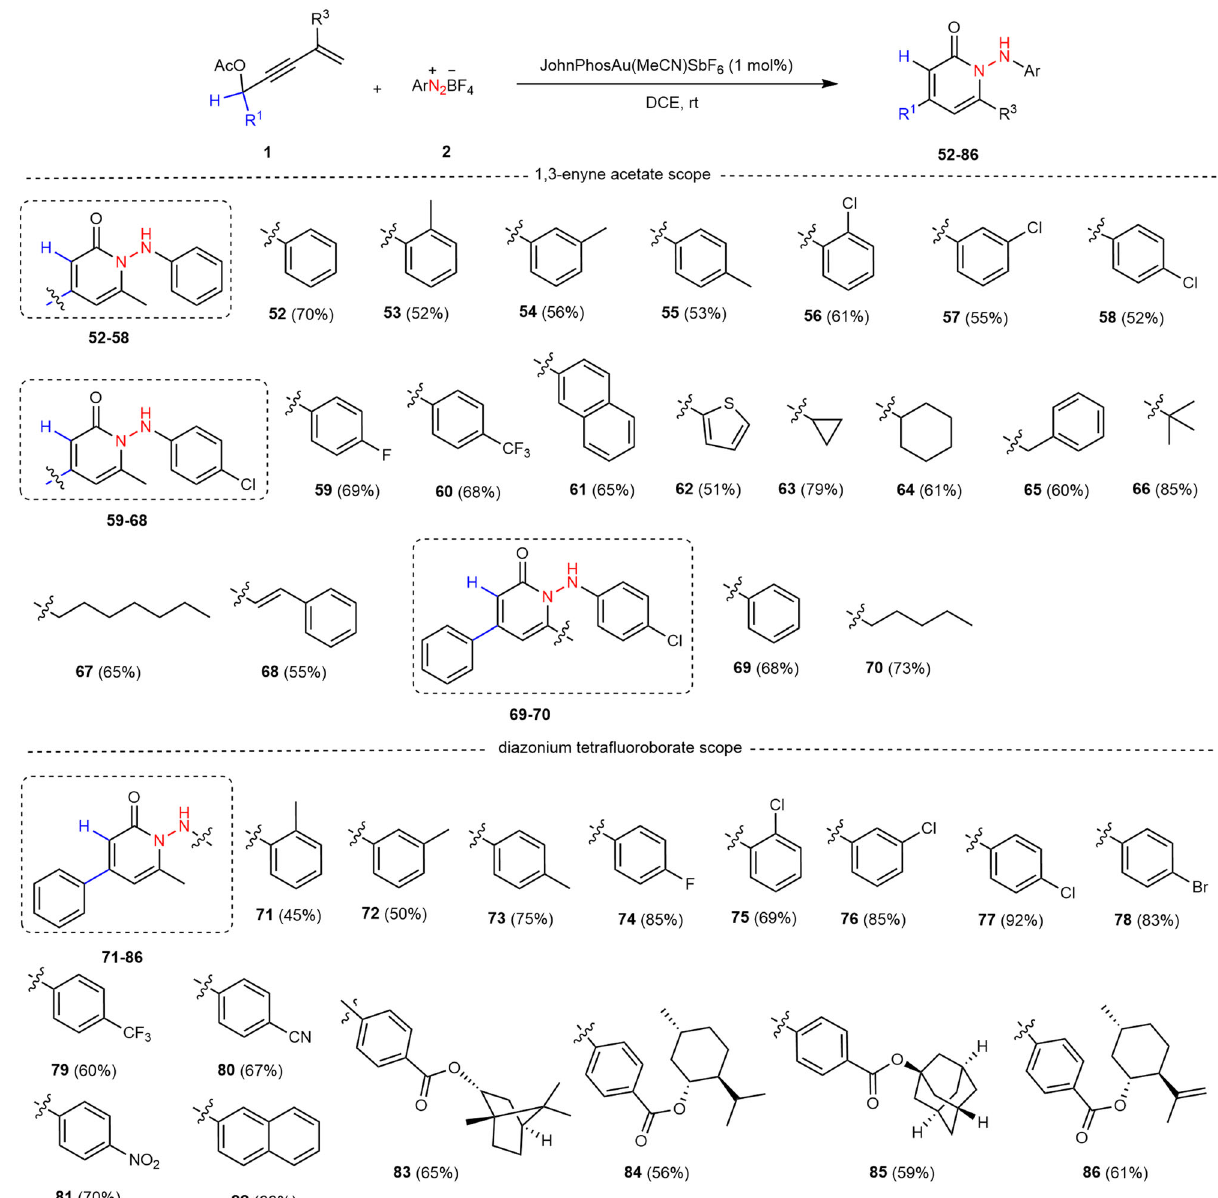
Fig.4|Schmidt-typereactionforthesynthesisofpoly-substituted2-pyridinones. Reactionconditions: 1 (0.2mmol), 2 (0.4mmol),JohnPhosAu(MeCN)SbF 6 (1mol%), DCE (2.0ml), room temperature (rt), 6h; the yield refers to isolated yield based on 1